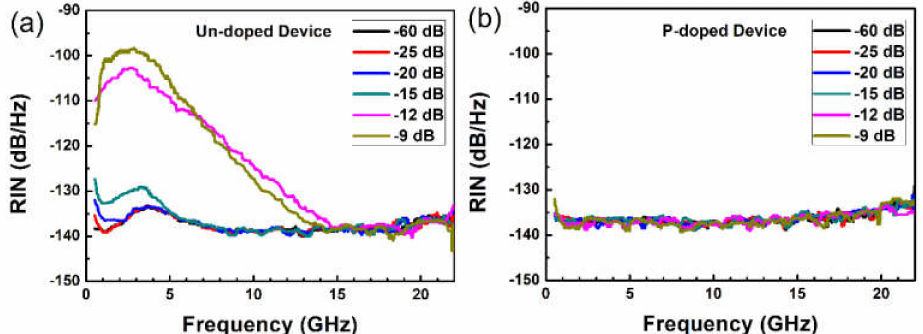
Figure 6. The relative intensity noise (RIN) spectra of devices measured at 65 mA with di ff erent optical feedback intensities. ( a ) Un-doped device and ( b ) p-doped